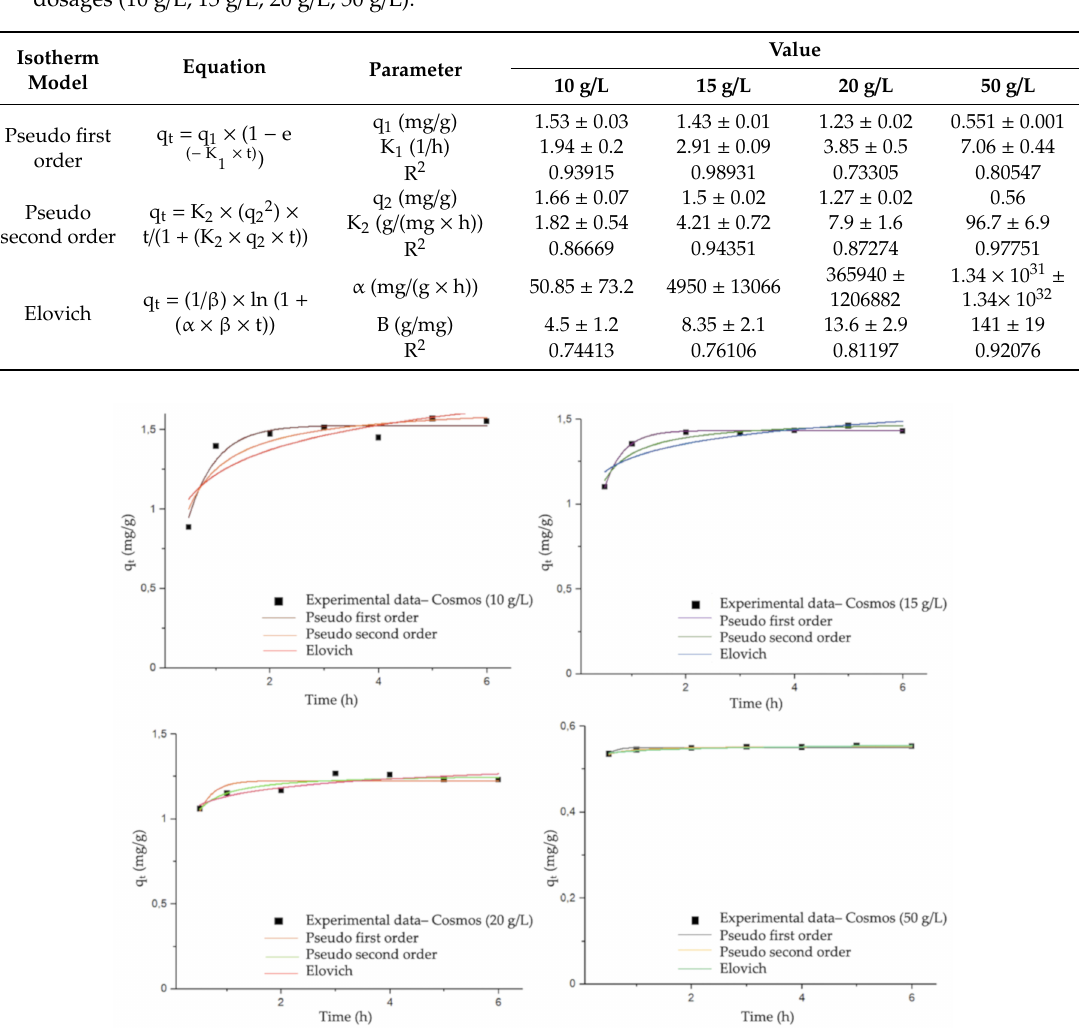
Table 1. Nonlinear kinetic parameters for the adsorption of DCF onto COSMOS (sample A) for all the